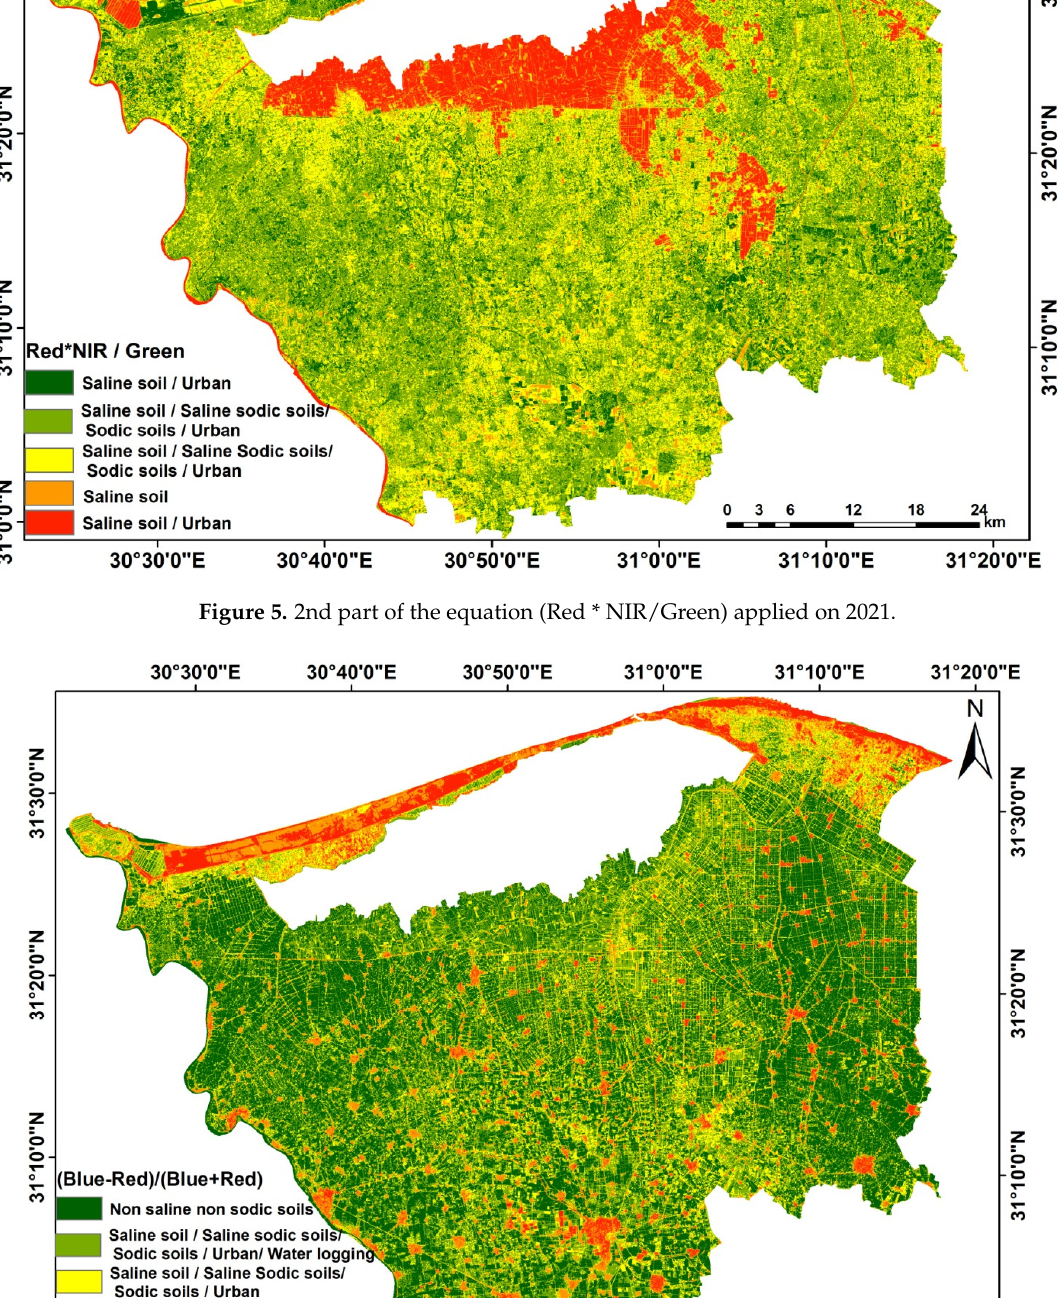
Figure 7 . Flowchart showing the main steps of the study. 2.4. Empirical Models Development Statistical and mathematical models were developed to model vegetation canopies, soil moisture, and soil salinity. Research in this area has resulted in considerable im- provements in estimating soil salinity, its spatial distribution, and the interaction be- tween electromagnetic radiation and saline soils. In an attempt to develop a new empir- ical model, the SI A values for the field soil sampling locations were regressed with the lab-estimated salinity EC measurements. Various regression models were developed, including linear and logarithmic; however, the exponential relation portrayed the high- est R-square values. The exponential relation is ideal with soil salinity indices due to their low saturation levels. The developed semi-empirical models were later applied for the Landsat for generating soil salinity and soil salinity class maps.